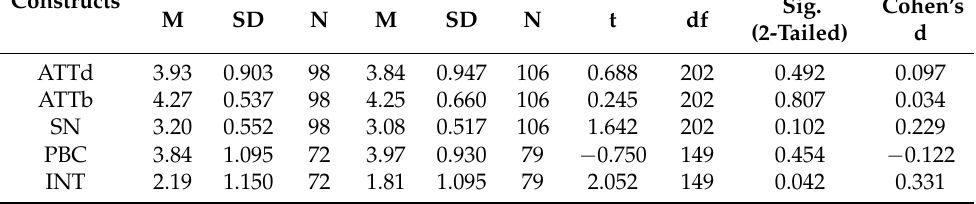
Table 6. Independent samples’ test results of children and adolescents: differences before and after the SMI—control group. Constructs